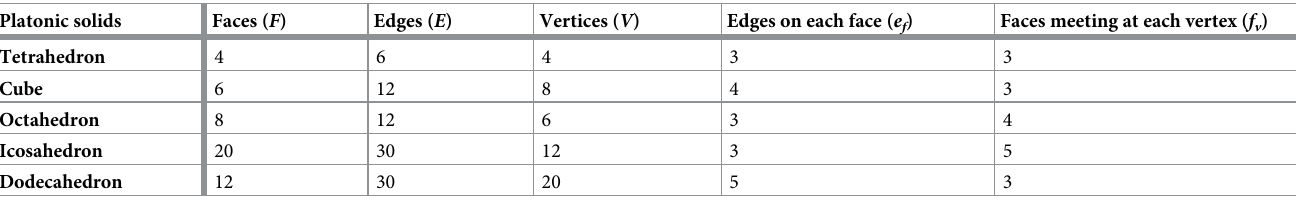
Table 1. Properties of